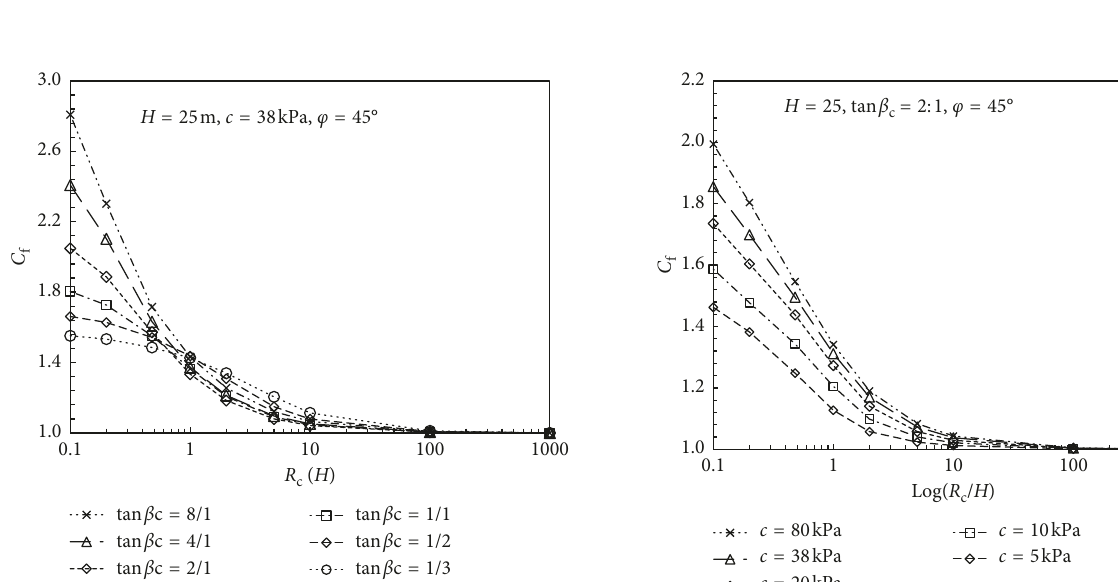
Figure 6: Critical failure planes for different R